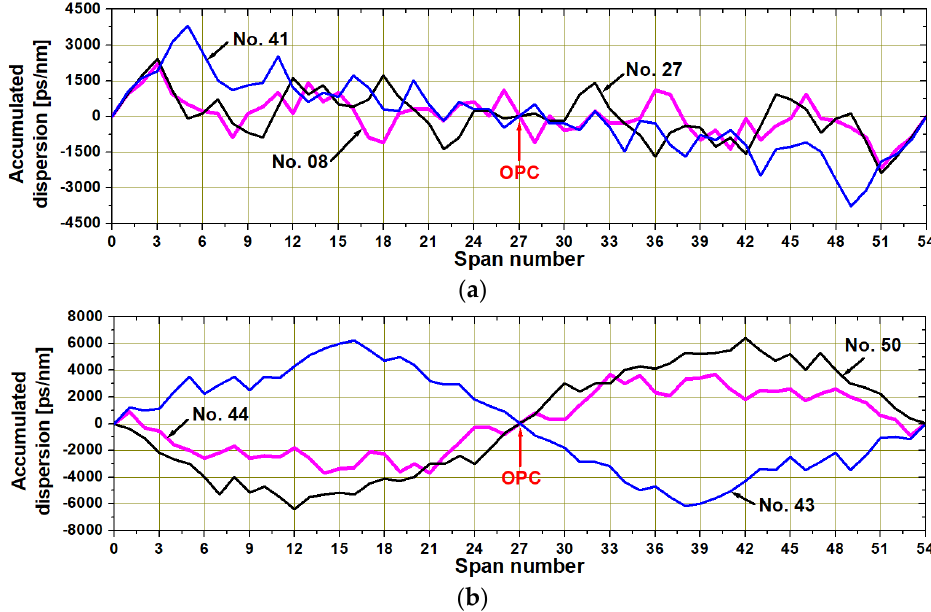
Figure 8. The dispersion maps established by random-inverse distribution of RDPSs. ( a ) The best compensation cases, and ( b ) the worst compensation